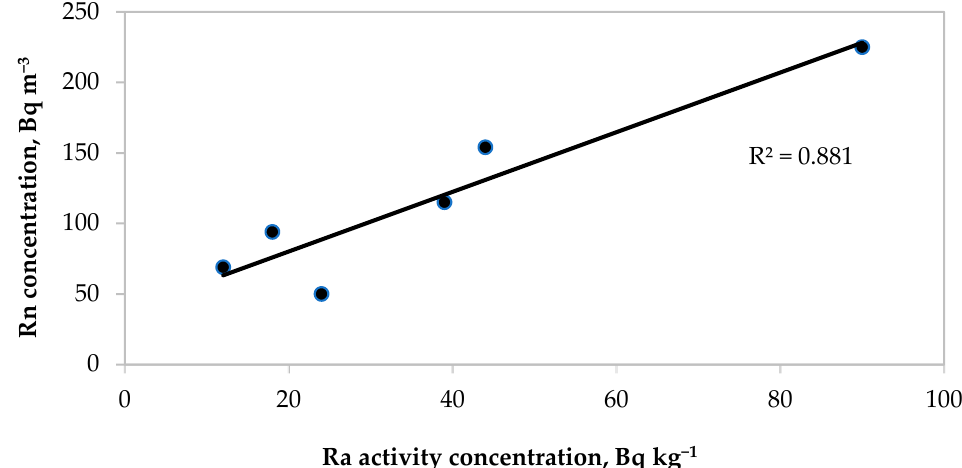
Figure 1. The correlation between radon concentration and radium activity concentration. Research of radon activity concentrations in underground parking lots with work- places has shown that people work in a safe environment in terms of radiation safety. The radon activity concentration varied from 22 ± 3 to 270 ± 18 Bq m − 3 (the average value was 83 ± 7 Bq m − 3 ). Indoor radon activity concentration did not exceed the level of the Lithuanian hygiene standard [11]. However, several cases were close to the maximum level. Such results may have been due to the fact that no mechanical ventilation systems were installed that do not allow radon to accumulate on the lower floors of the building.